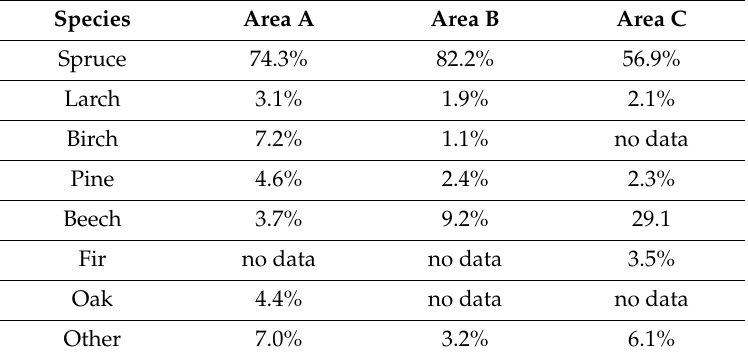
Figure 2. Study area A (Western Sudety), B (Eastern Sudety) and C (Western Beskidy)–State Forests. Table 1. Forest structure in three areas: A—Western Sudety, B—Eastern Sudety and C—Western Beskidy [Forest Data Bank, 2019].